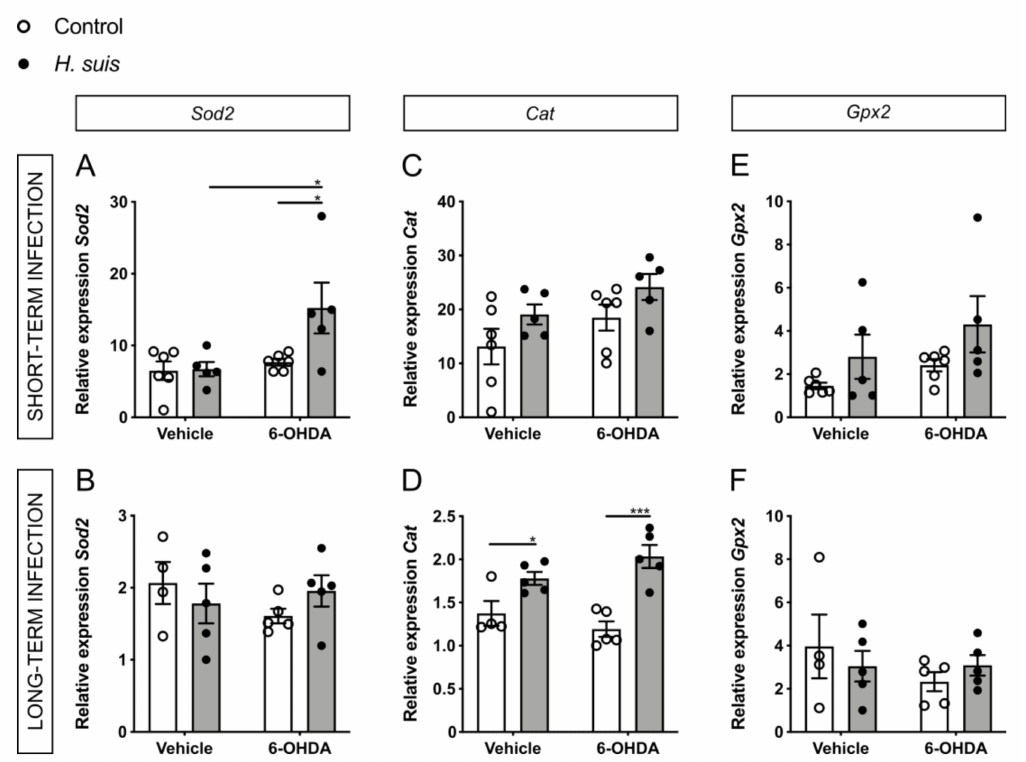
Figure 7. Helicobacter suis ( H. suis ) infection is associated with an increased gene expression of endogenous peroxidases. ( A – F ) Relative mRNA gene expression of the endogenous peroxidases super oxide dismutase 2 ( Sod2 ) ( A , B ), catalase ( Cat ) ( C , D ), and glutathione peroxidase 2 ( Gpx2 ) ( E , F ) in the forebrain, 7 days after intrastriatal injection with either 6-hydroxydopamine (6-OHDA) (n = 5) or vehicle (n = 4–5), of mice infected with H. suis (black) or the control broth (white) for a short-term period ( A , C , E ) or a long-term period ( B , D , F ). * 0.01 ≤ p < 0.05; *** 0.0001 ≤ p <